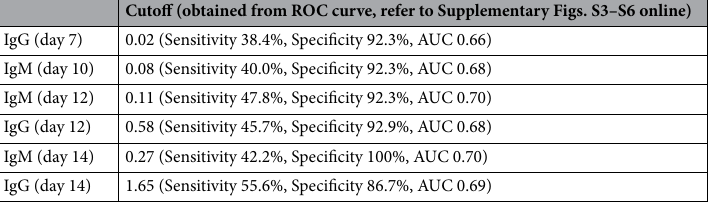
Cutoff (obtained from ROC curve, refer to Supplementary Figs. S3–S6